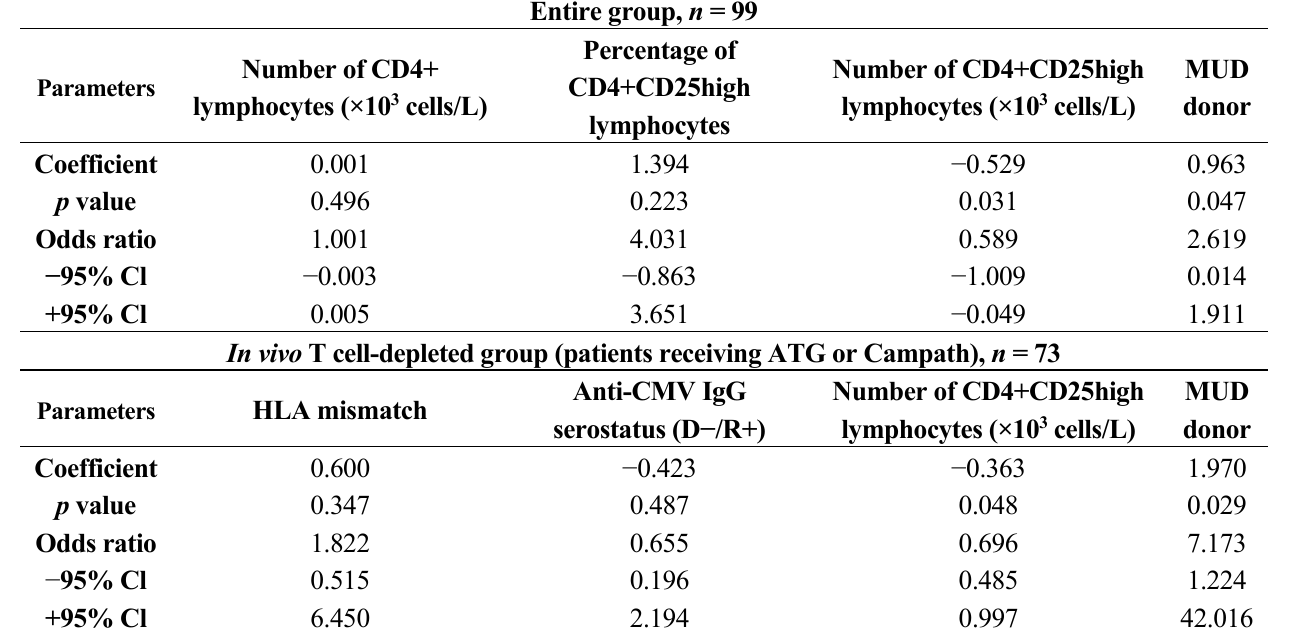
Figure 2. Numbers of CD4+CD25high lymphocytes in the blood at hematologic recovery in patients with and without acute graft- versus -host disease (aGvHD) at the time of examination or at a later time point post-transplant. Table 3. Multivariate analyses of the factors associated with aGvHD (grades